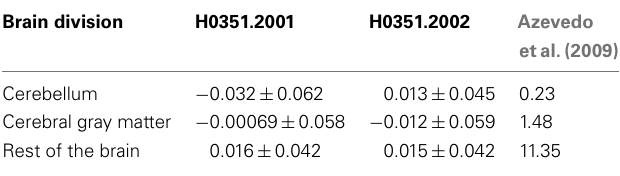
Table 3 | PC1 brain loadings (mean ± standard deviation) of the two AIBS human datasets and measured glia to neuron ratio from Azevedo et al. (2009) in cerebellum, cerebral gray matter, and remaining brain